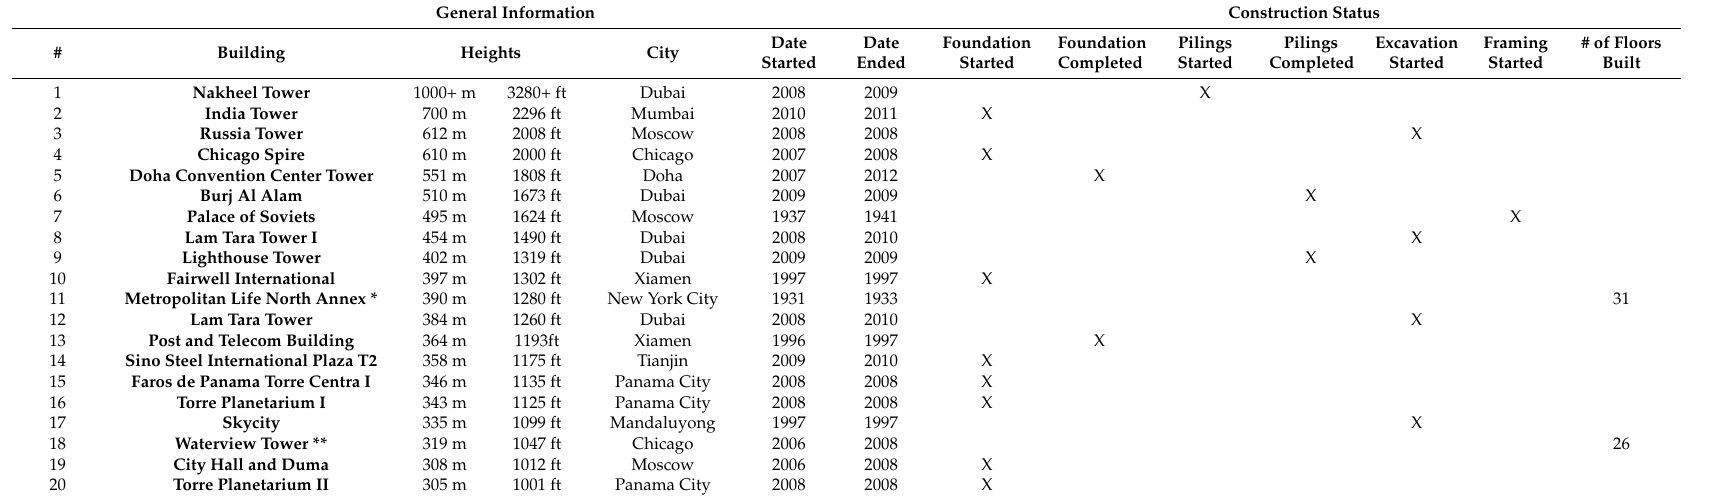
Table 5. Tallest unfinished buildings, based on CTBUH data, 2014